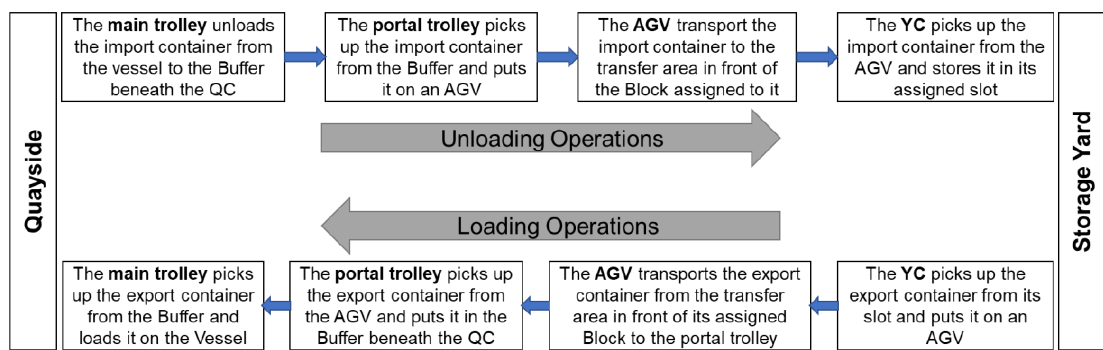
Figure 3. Loading and unloading operations in an ACT .